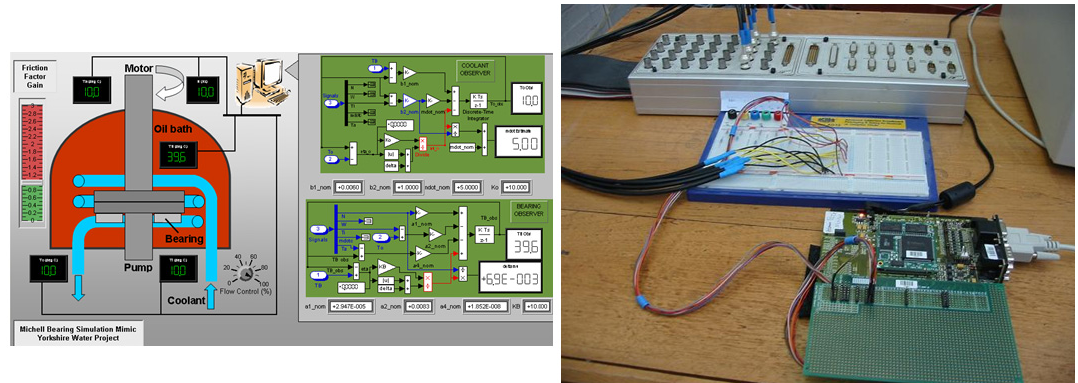
Figure 8. HIL testing of the prototype edge device on a C167 processor.